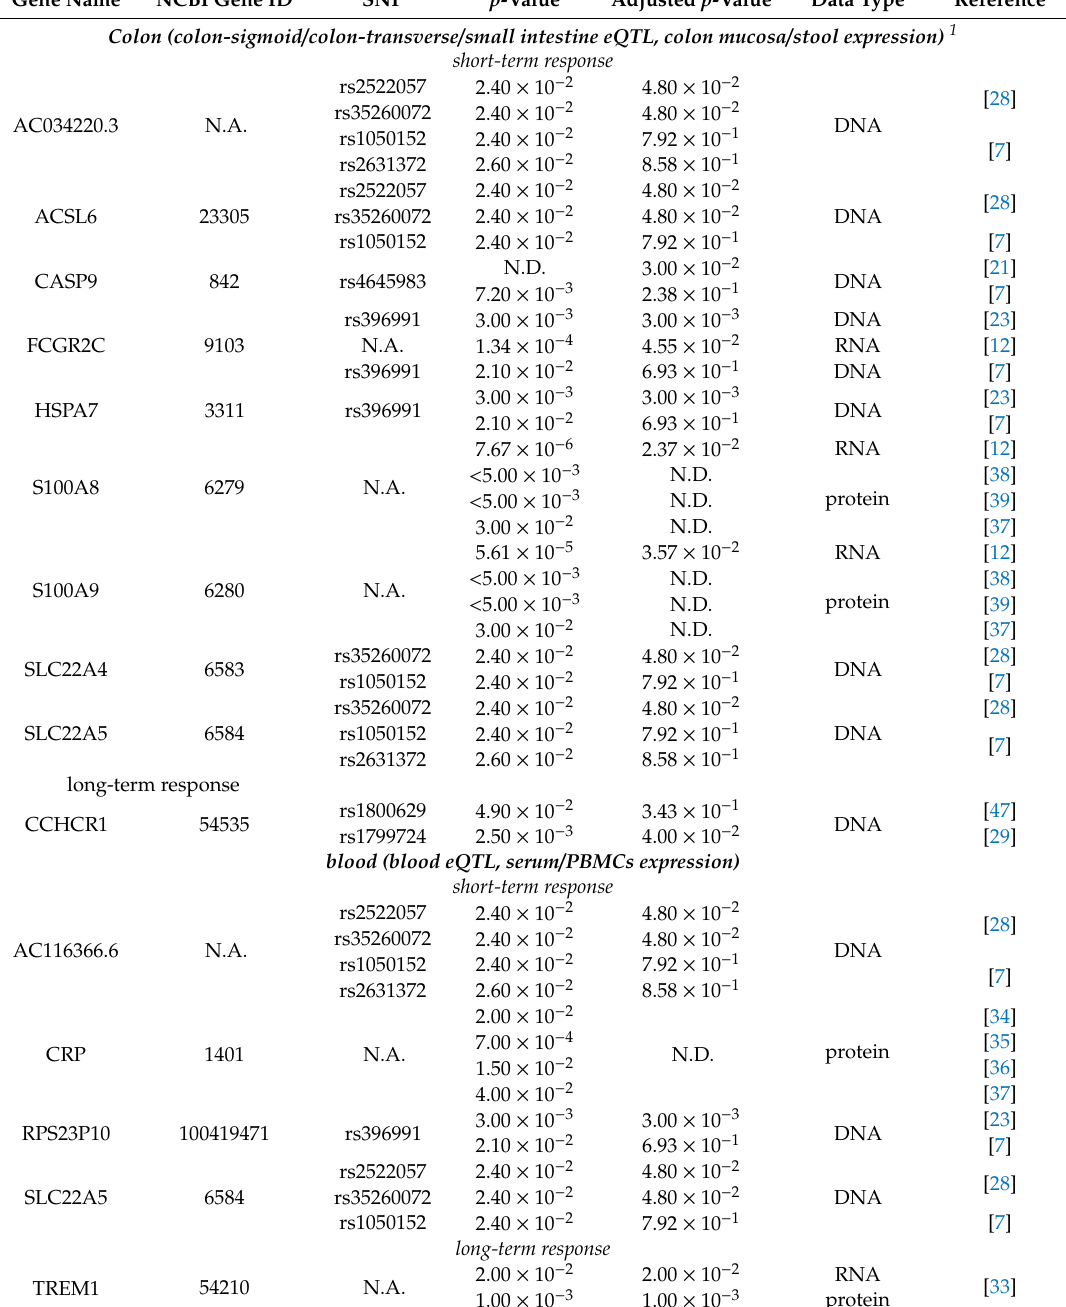
Table 4. Independently confirmed integrated markers linked to anti-TNF response in CD